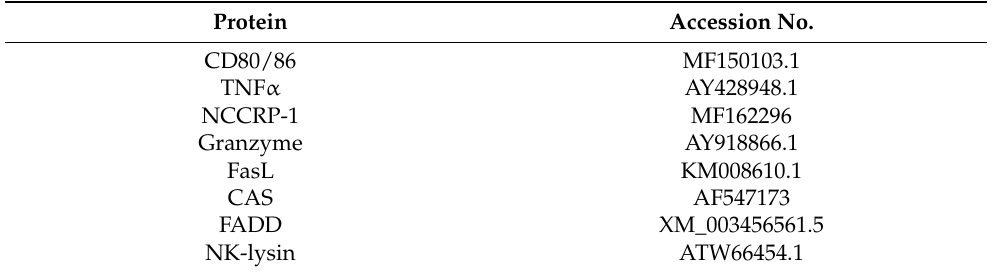
Table 2. GenBank accession numbers of relative genes of tilapia used in this study. Protein Accession